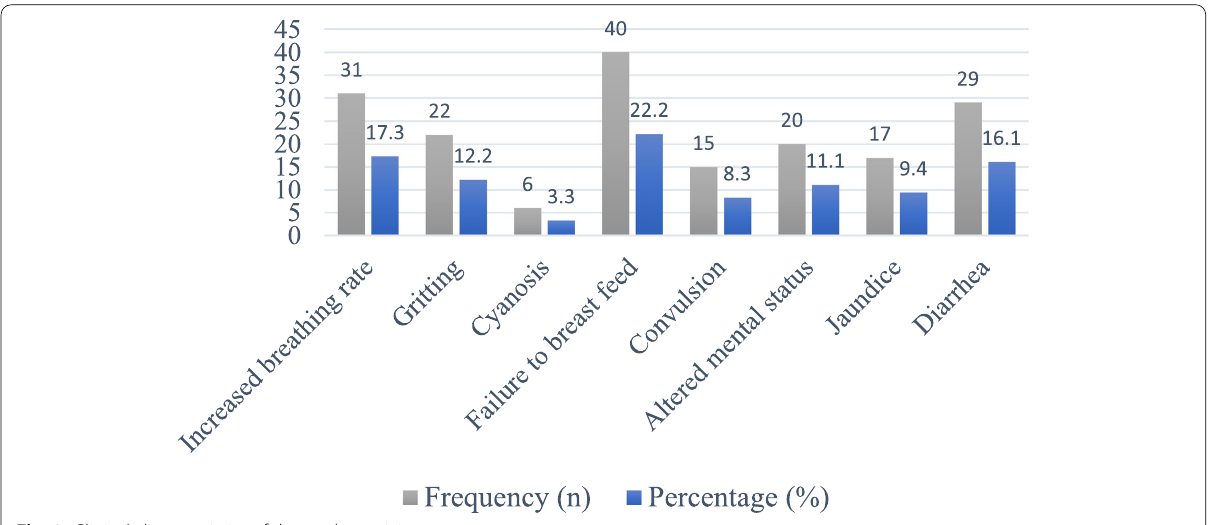
Fig. 2 Clinical characteristics of the study participants